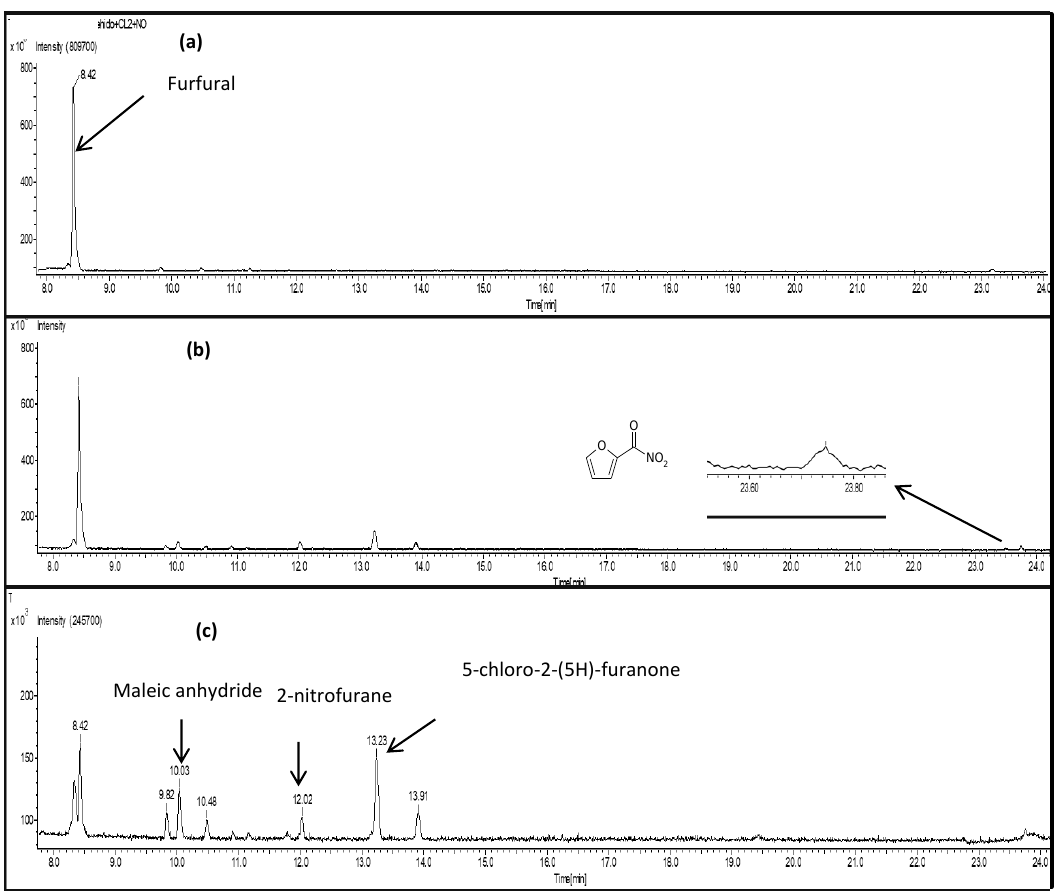
Figure 2. Gas chromatograms obtained for the reaction of furfural with chlorine atoms in the presence of NO at di ff erent times: t = 0 min ( a ), t = 5 min ( b ) and t = 10 min ( c